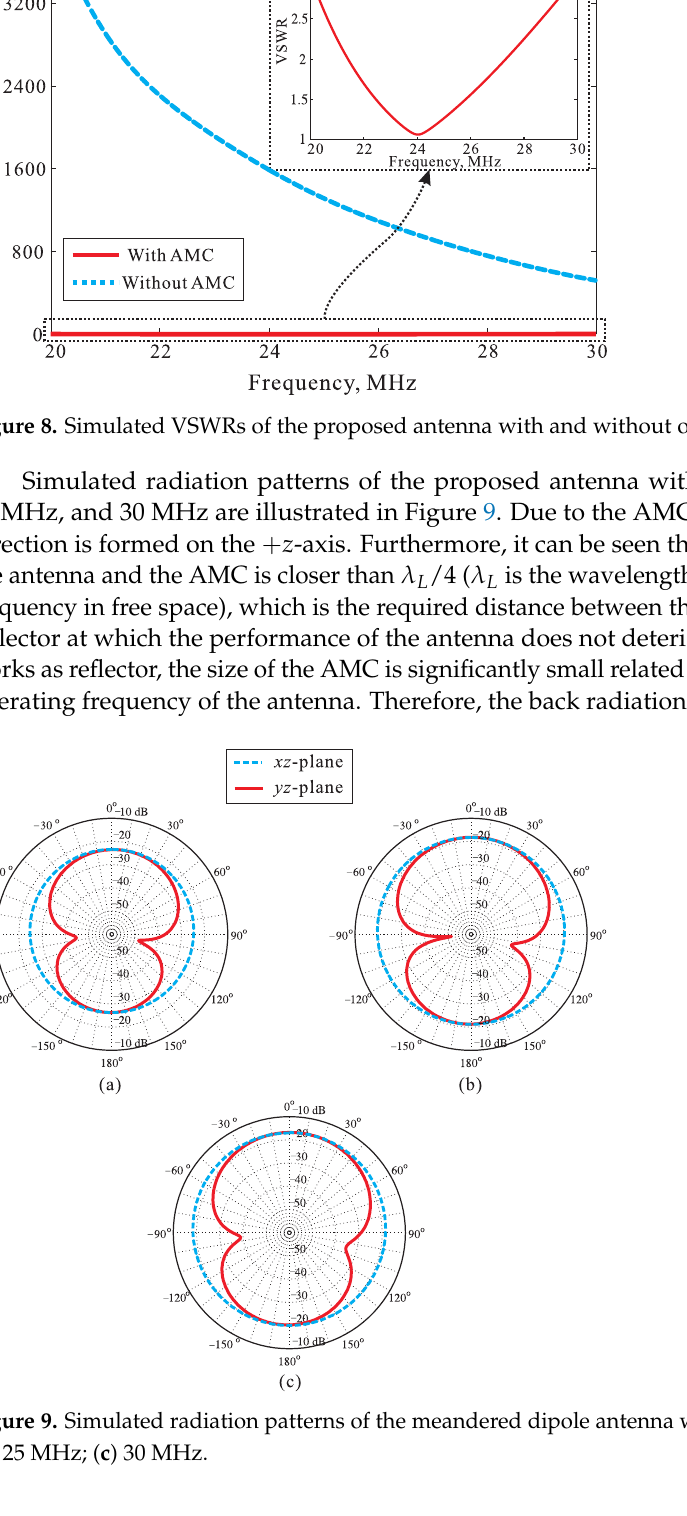
Figure 9. Simulated radiation patterns of the meandered dipole antenna with the AMC : ( a ) 20 MHz; ( b ) 25 MHz; ( c ) 30